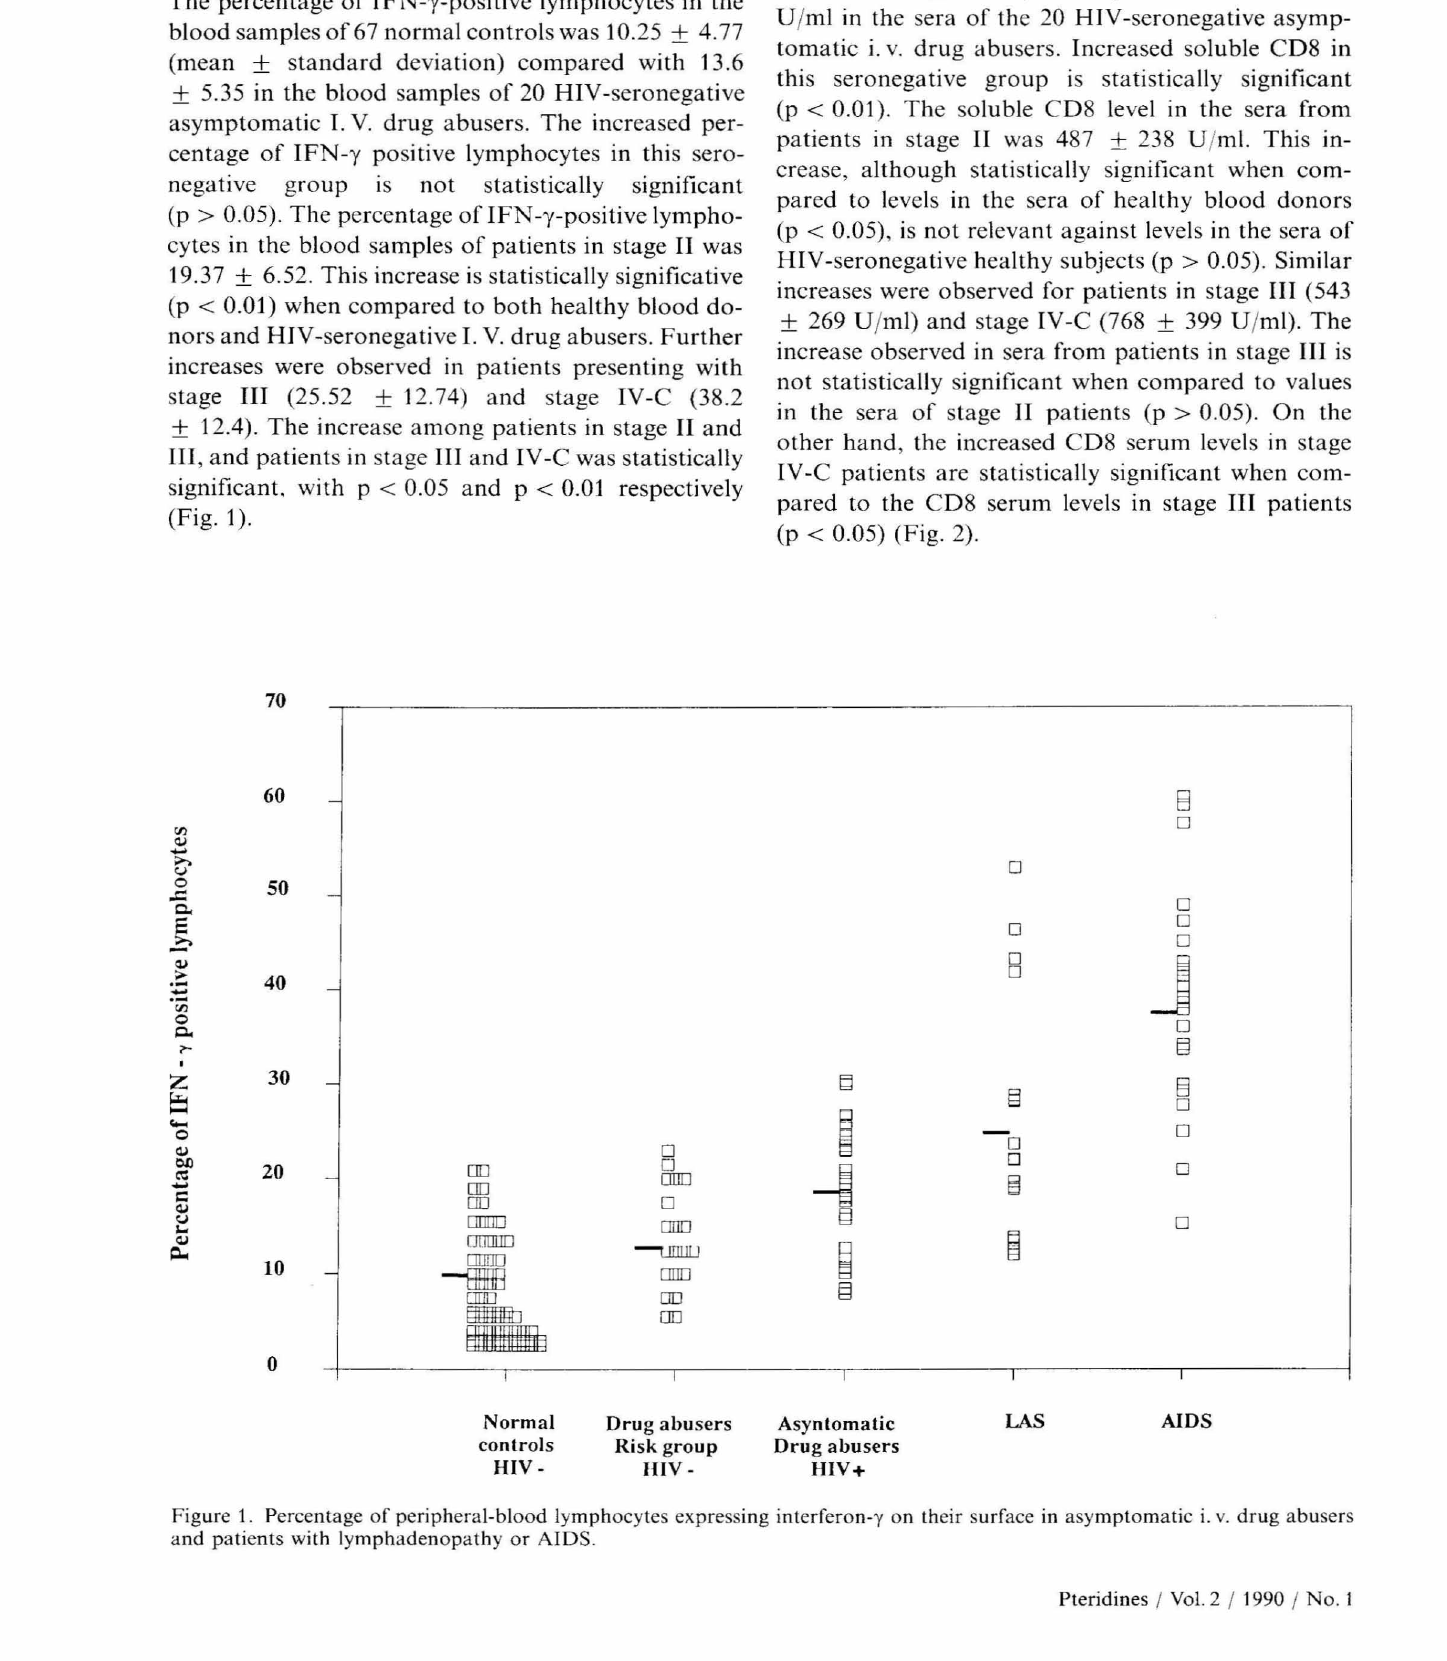
aFnigdupreat11.e· nPtserc~tnhtalge ofhPderipherahl-blood lymphocytes expressing interferon-yon their surface in asymptomatic i v drug abusers WI ymp a enopat y or